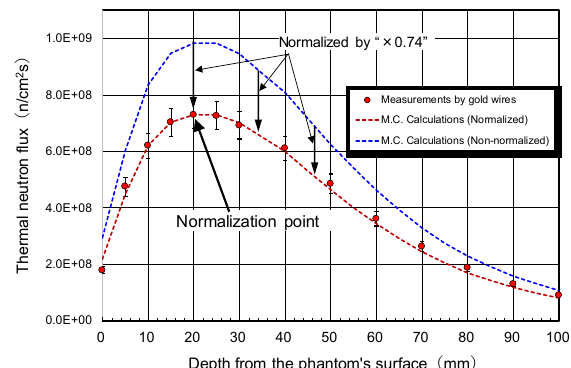
Fig. 4 Thermal neutron flux on the beam axis